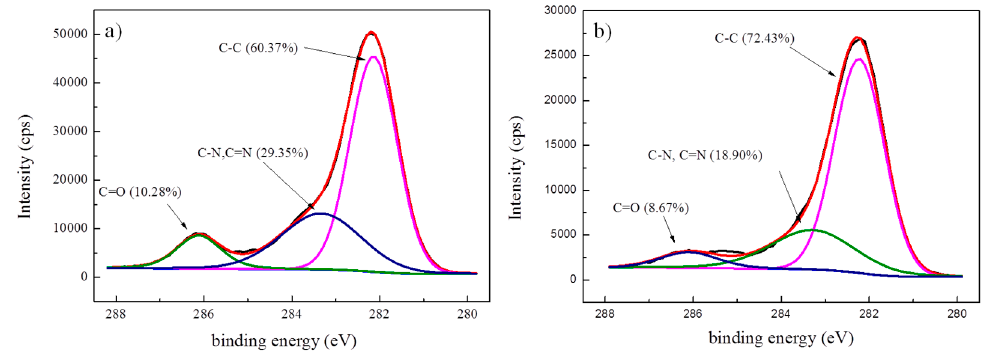
Figure 4. C1s spectra and concentrations of the correlative functional groups of the aramid fiber samples. ( a ) Untreated fibers and ( b ) modified fibers of sample 2 in Table 1.